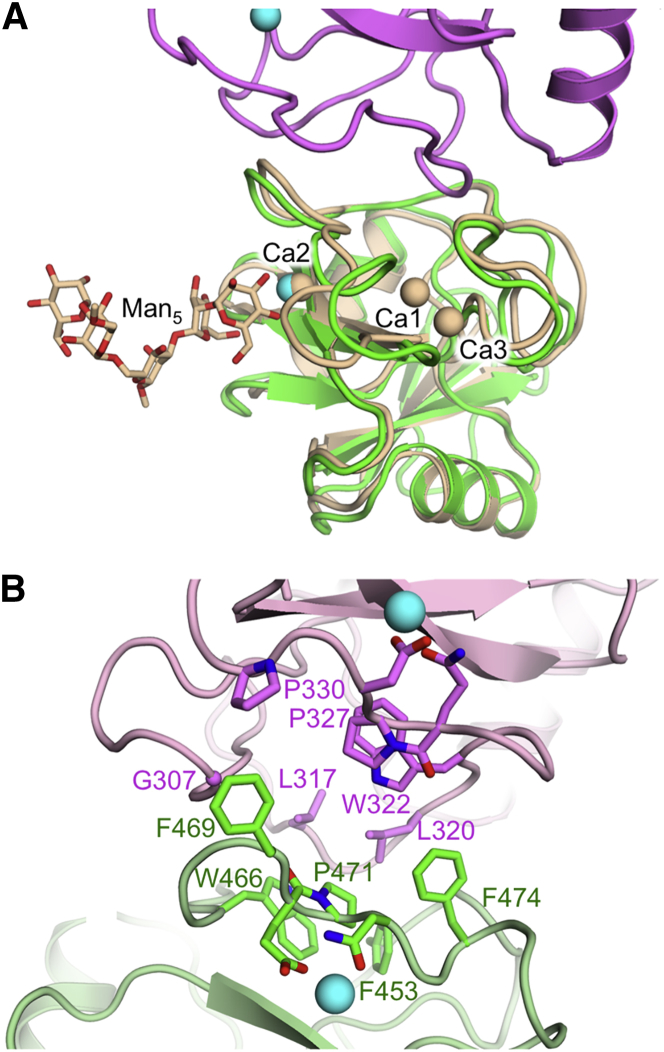
C-Type Lectin Domains 1 and 2 of Endo180(A) Superposition of CTL2 of Endo180 (green) with rat mannose-binding protein bound to an oligomannose ligand (wheat) (Weis et al., 1992). The Endo180 CTL1 domain is shown in pink. Sodium and calcium ions are shown as cyan and wheat-colored spheres, respectively.(B) The CTL1-CTL2 interface in Endo180. CTL1 and CTL2 are shown in pink and green, respectively. Selected residues are shown as sticks.